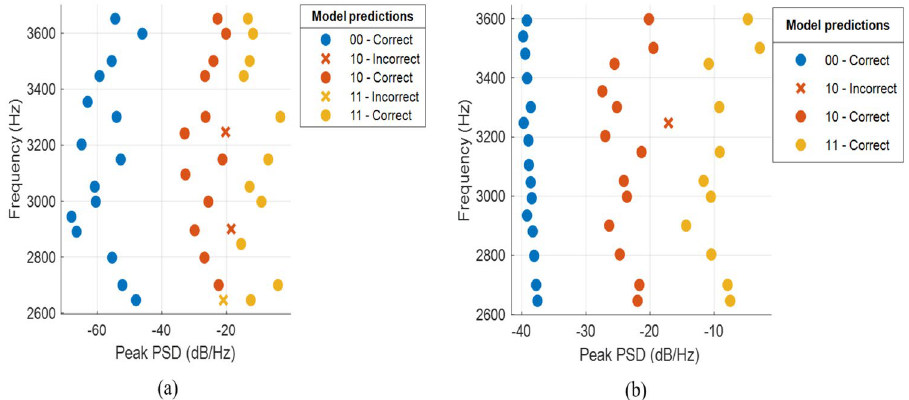
Fig. 6 the classification of stator current’s PSD a AR based Burg, b Welch